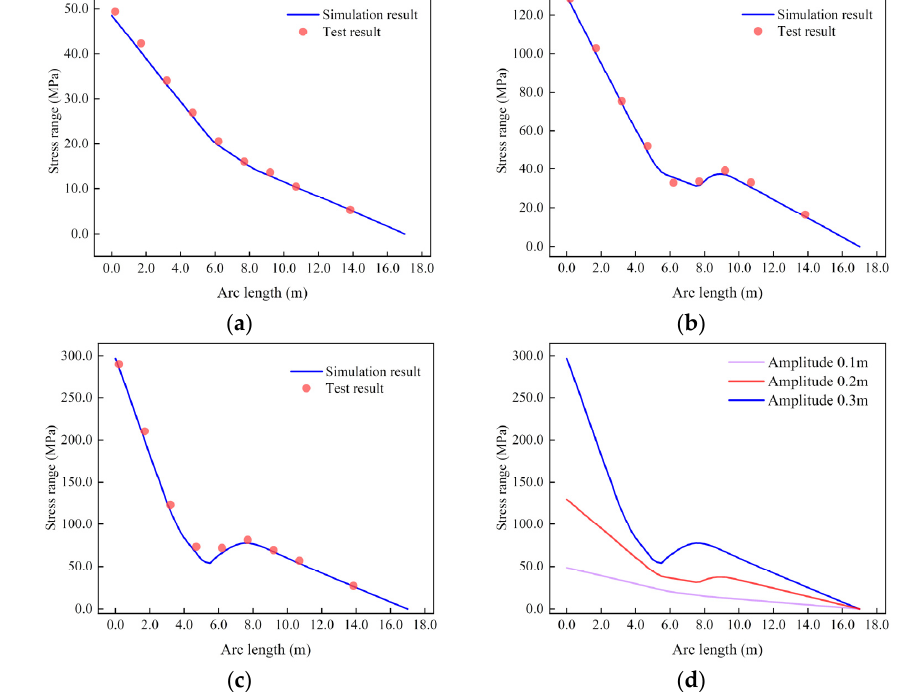
Figure 30. In-plane stress range distribution under different loading amplitudes: ( a ) 100 mm; ( b ) 200 mm; ( c ) 300 mm; ( d ) comparison of the stress ranges.